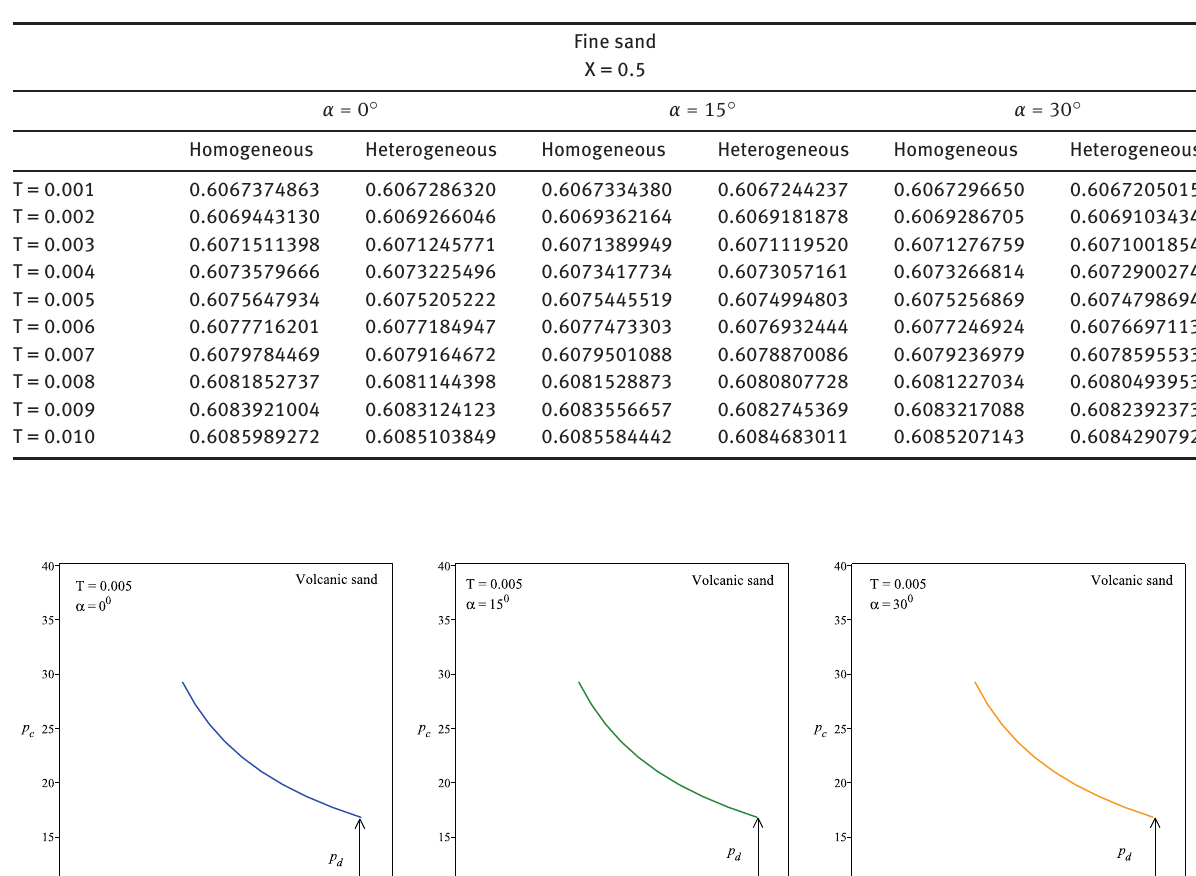
Table 4: Saturation of water in Fine Sand for Homogeneous and Heterogeneous Inclined Porous Media